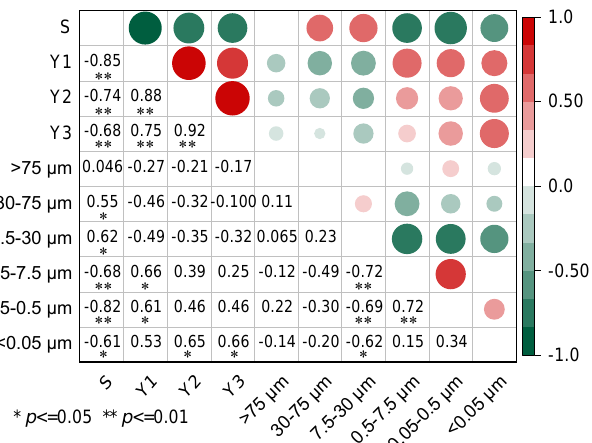
Figure 5. Correlation analysis between soil pore size distribution, migration distance, and residual amount of diesel in the 0–3 cm soil